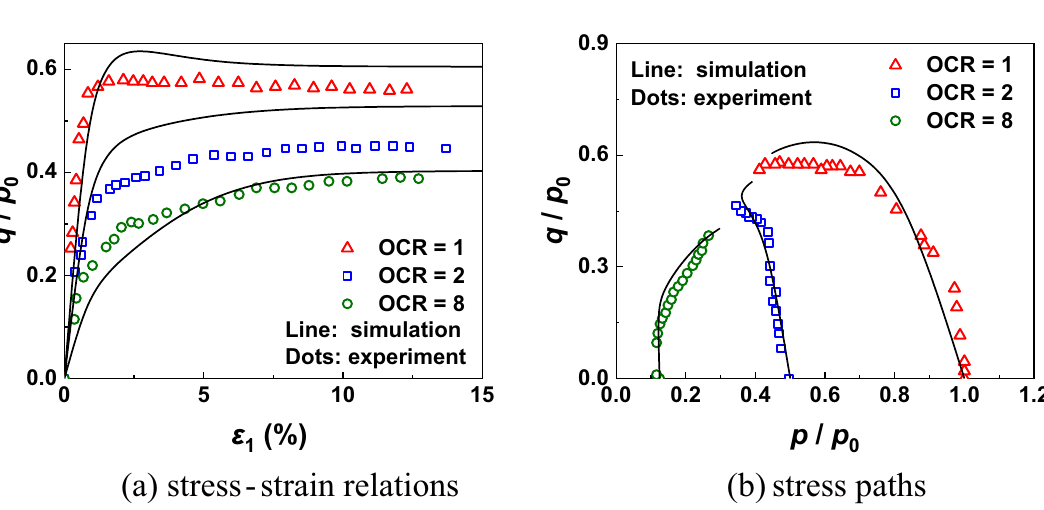
Figure 7. Model predictions and experiment results of Boston blue clay under undrained conditions.